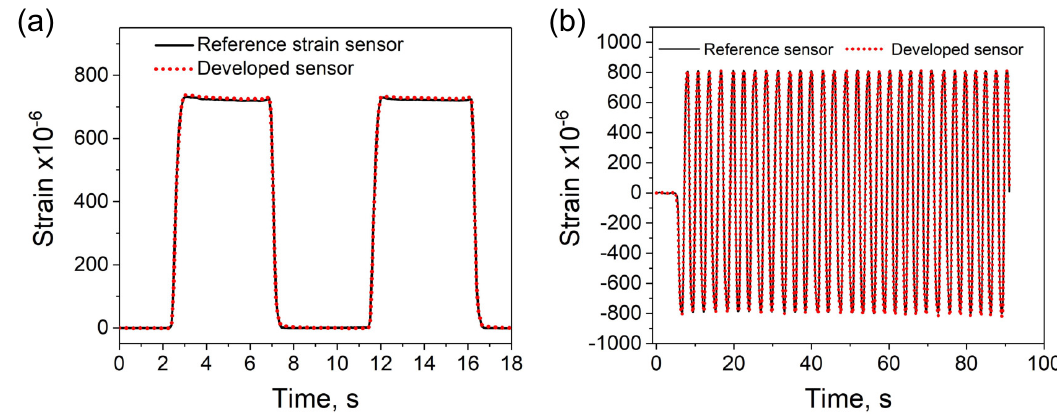
Figure 8. Analysis of the developed sensor under ( a ) static ( b ) and dynamic strains. The recorded output signal shows a good correlation with the reference strain